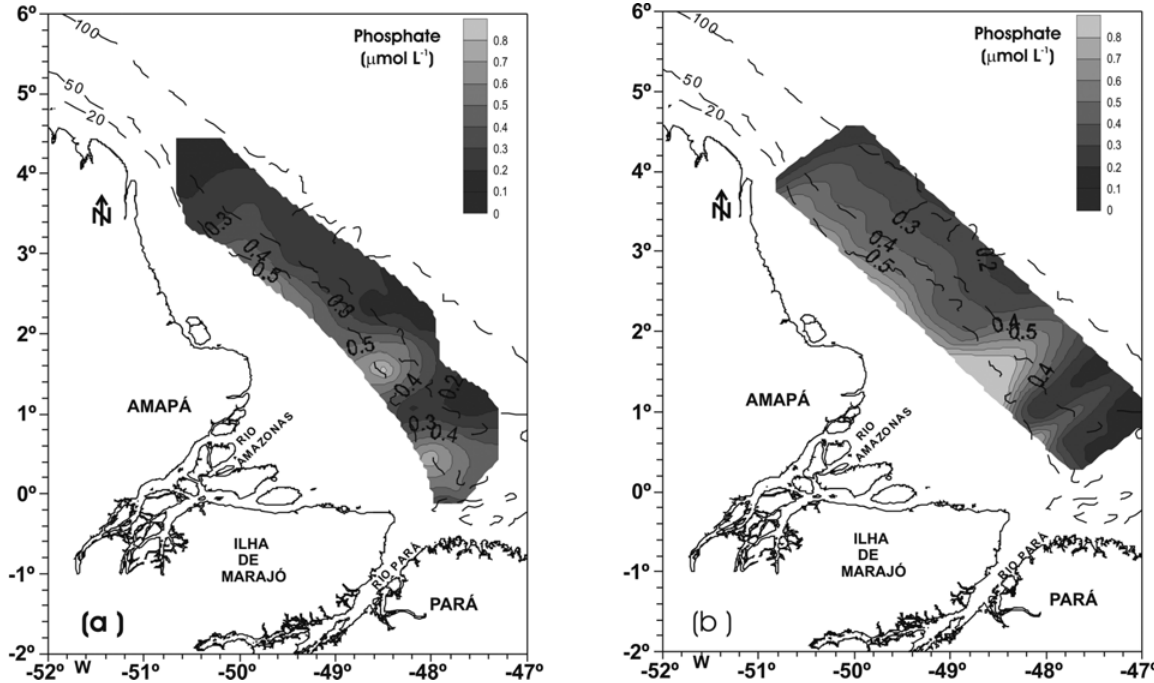
Fig. 9 – Distribution of the superficial concentration of the phosphate during Operation Norte III (high discharge of the Amazon river): (a) REVIZEE data; and (b) MACC-2D model results.